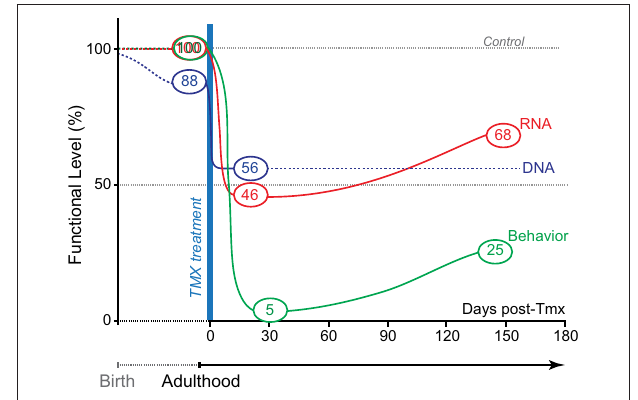
FIGURE 5 | Genetic pharmacotherapy for glutaminase inhibition. The relative timing and magnitude of DNA, RNA, and behavioral effects are schematized prior to and after Tmx treatment. Black dotted line shows extrapolated DNA levels. Prior to Tmx, there was significant leaky recombination, but this did not impact GLS1 mRNA levels or behavior (amphetamine-induced locomotion). After Tmx, there was full recombination. At short and long-time points post-Tmx, both mRNA levels and amphetamine-induced hyperlocomotion showed the maximum effect at the short-time point. As in constitutive GLS1 Hets, amphetamine-induced hyperlocomotion was blocked at the short-time point, and strongly attenuated at the long-time